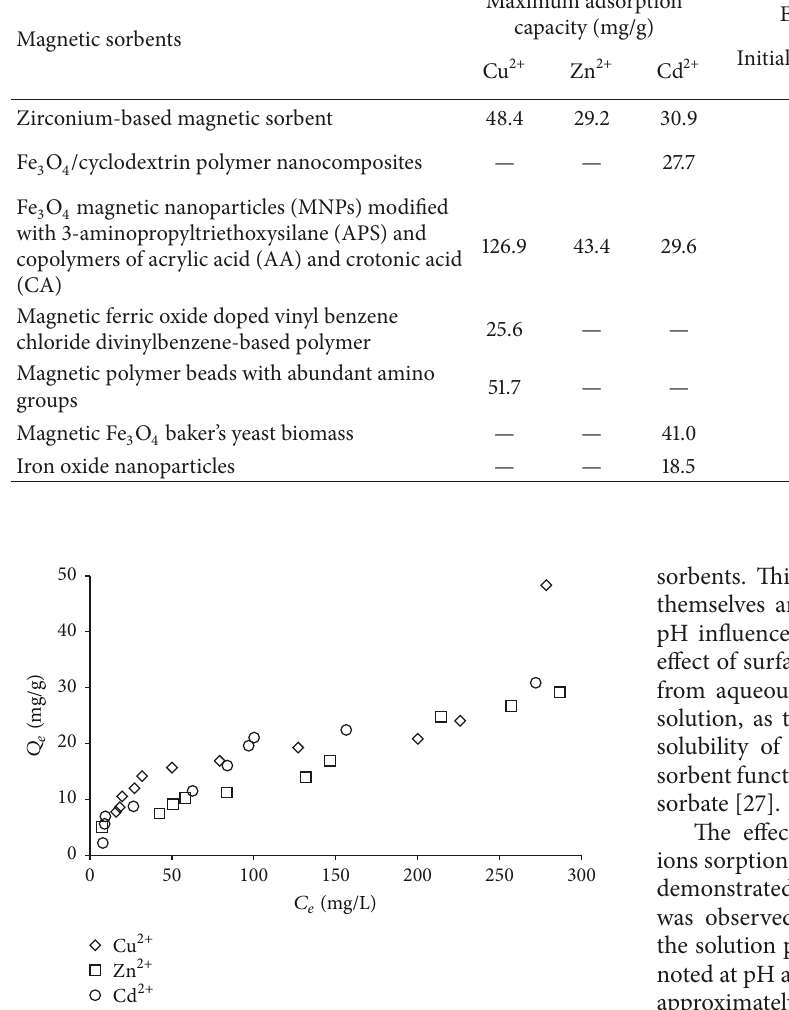
increased hence intensifying the mass transfer processes